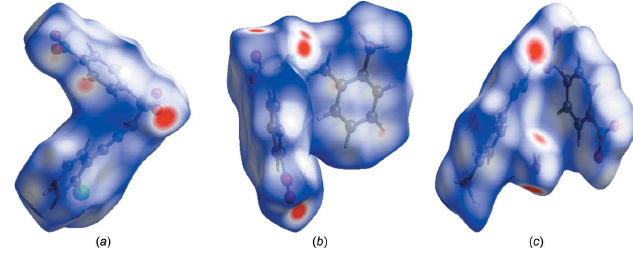
Figure 8 The crystal packing of compound (III), viewed along the b axis, with hydrogen bonds shown as dashed lines.